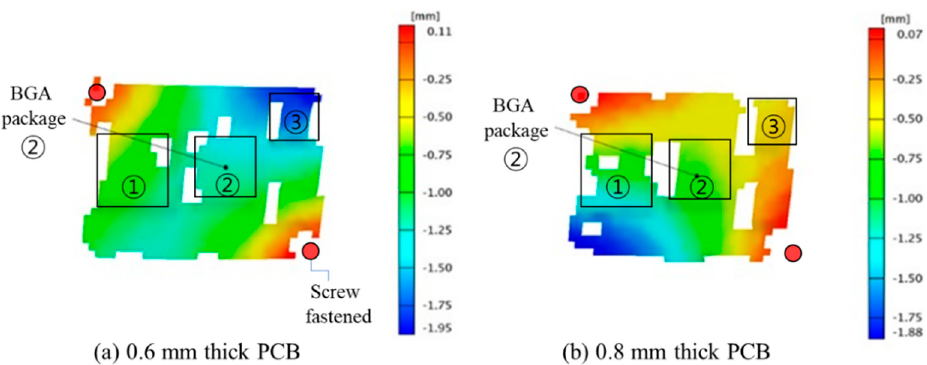
Figure 6. Out-of-plane displacement contour plots for PBA with fixture I.